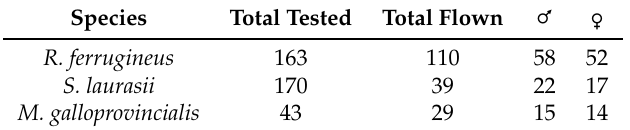
Table 3. Number of tested insects and the number of individuals able to fly from each insect species.